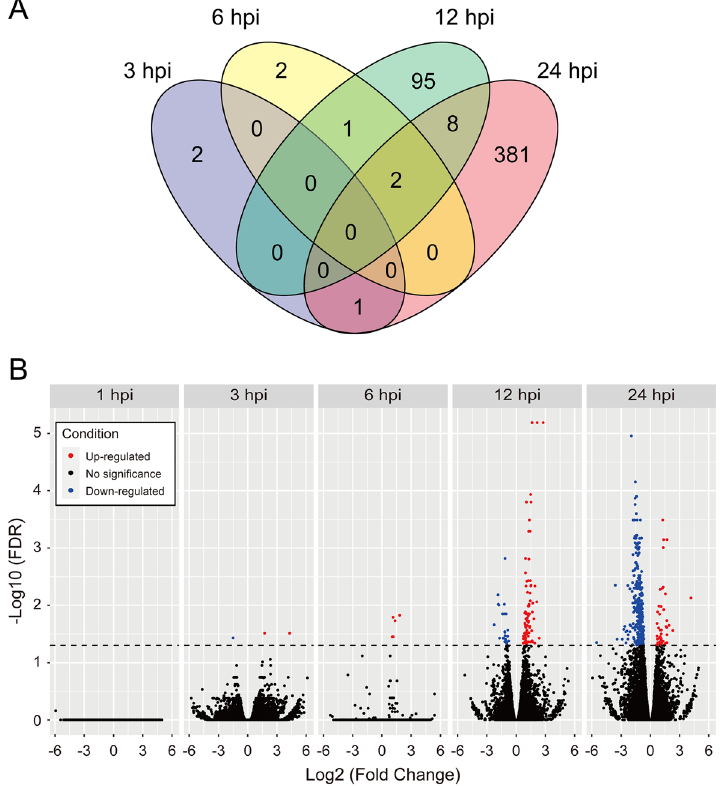
Figure 2. Transcriptomic changes of Acropora tenuis larvae during initial contact with native symbionts, Symbiodinium microadriaticum . ( A ) Comparison of DEG repertoires of Smic-inoculated larvae at 3, 6, 12, and 24 hpi. Raw data are provided in Supplementary Table S3. Hpi indicates hours post-inoculation. ( B ) DEGs that are upregulated or downregulated in Smic-inoculated larvae compared to controls are colored red or blue, respectively. The dotted line indicates FDR =